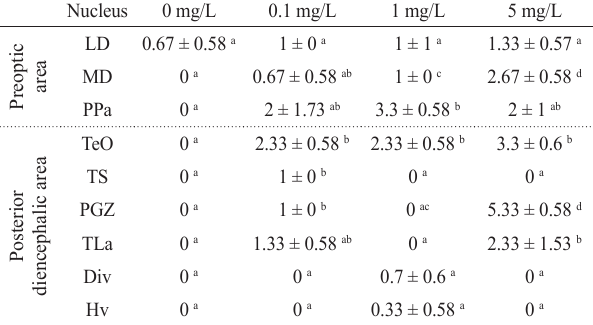
Tab. 1. Number of MC cells of Paracheirodon axelrodi at some preoptic area (AP) neuronal nuclei, posterior diencephalic area (PDR) at different Roundup Activo™ concentration. Each value does represent mean ± SD. Different letters correspond to significantly differences between treatments (P<0.05). Nuclei: LD: lateral area of dorsal telencephalum, MD: mid area of dorsal telencephalum,